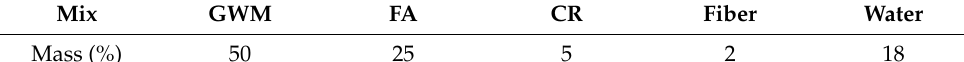
Table 4. Composition of the GMW-FA-CR Mix.